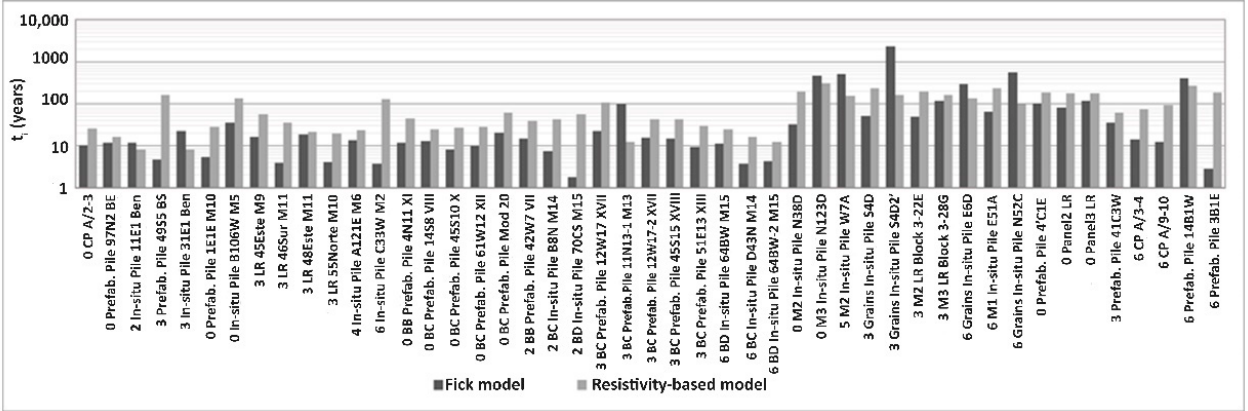
Figure 9. Comparison of models of t i by element.